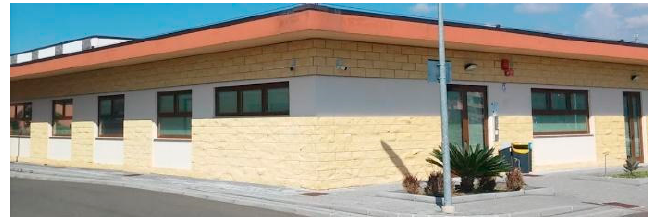
Figure 23. Technological pole building.